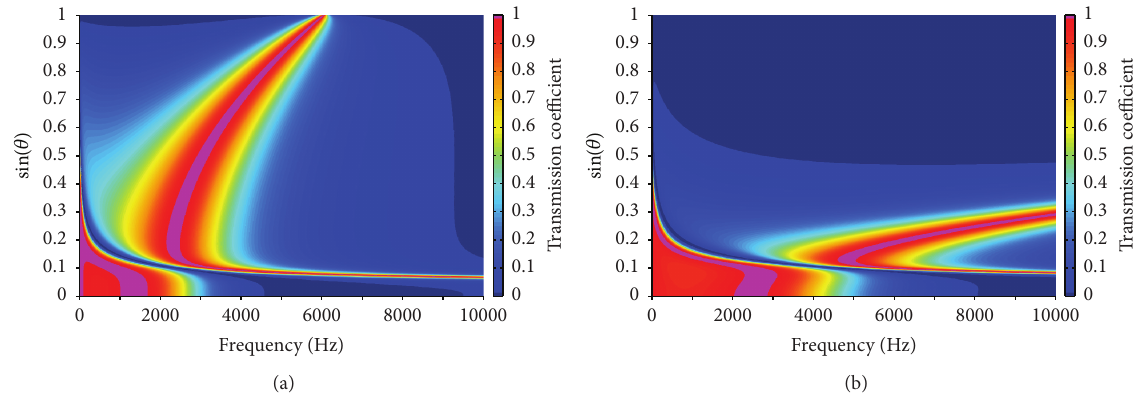
Figure 4: Transmission coefficients at different wave heading angles, 𝜃 , across one rib on the periodic ribbed plates that forms (a) Plate 2 on L-junctions A and B; (b) Plate 1 on L-junction B.